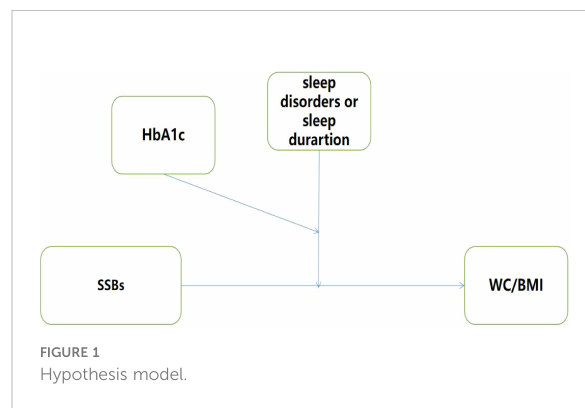
FIGURE 1 Hypothesis